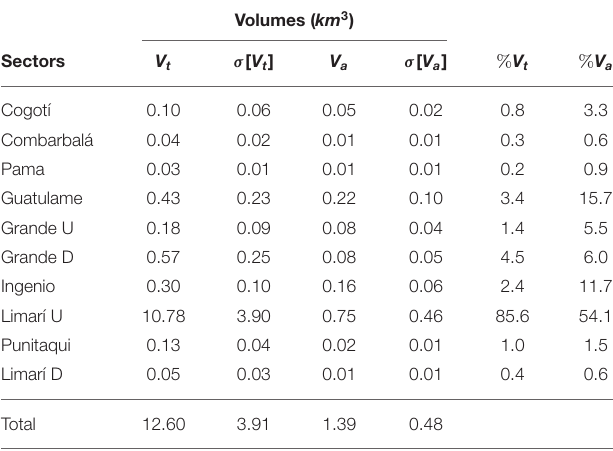
TABLE 4 | Volume of groundwater estimated in the sectors of hydrogeological continuity defined in Figure 4